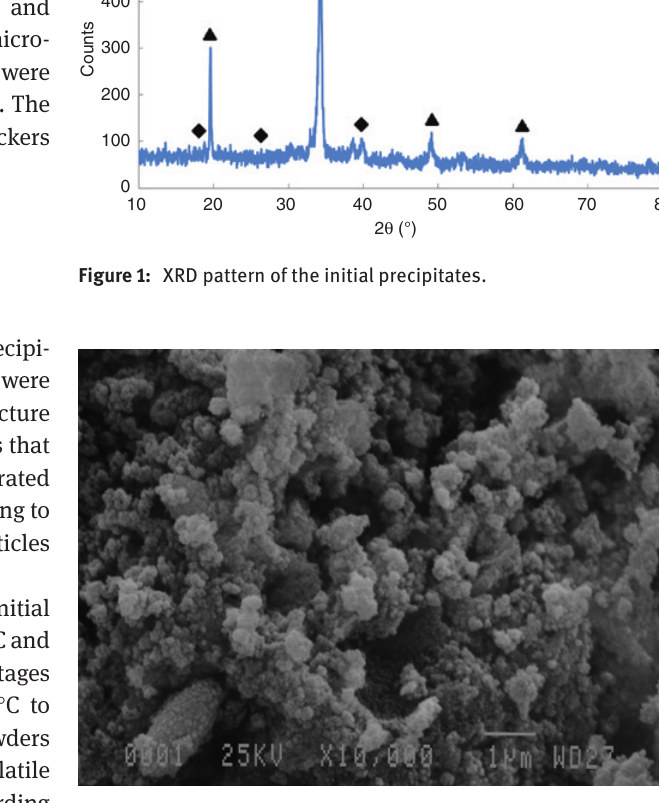
Figure 2: SEM image of the initial precipitates.